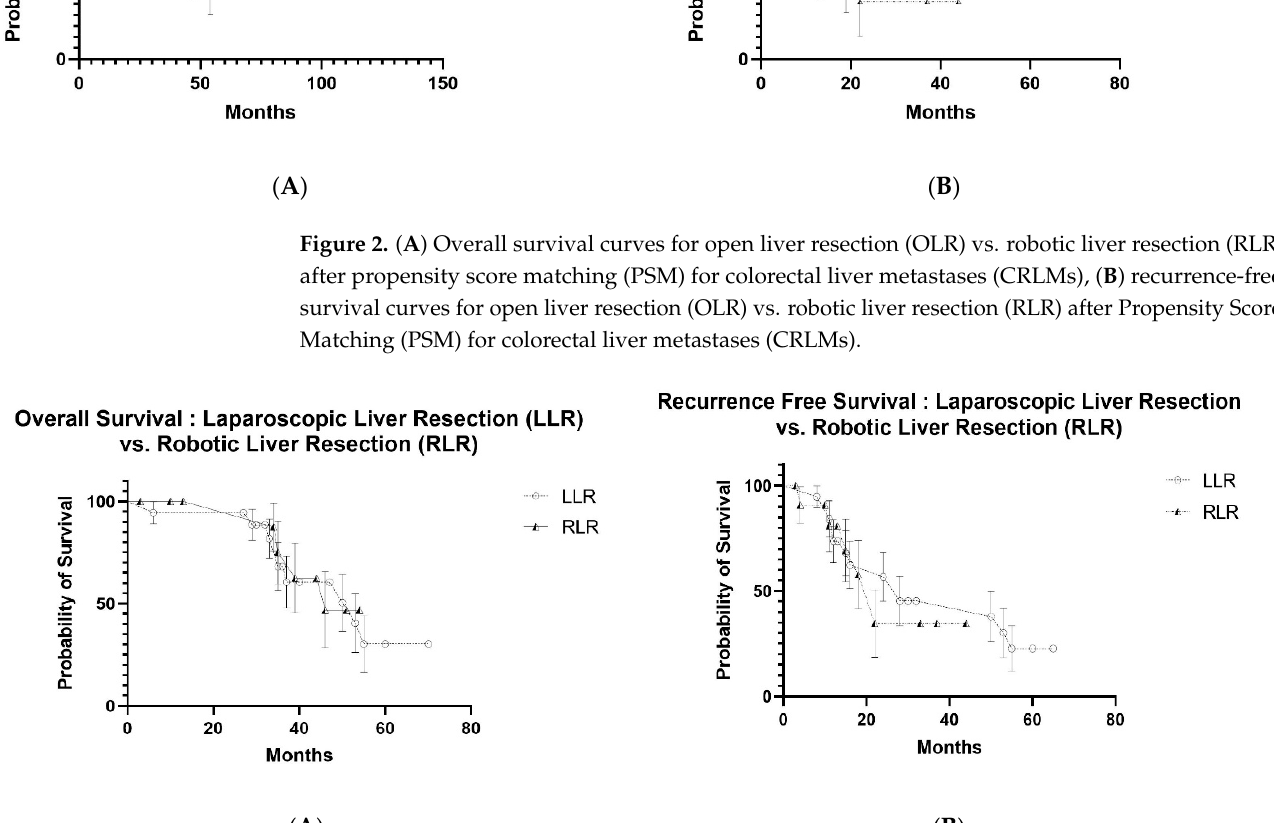
Figure 3. ( A ) Overall survival curves for laparoscopic liver resection (LLR) vs. robotic liver resection (RLR) after propensity score matching (PSM) for colorectal liver metastases (CRLM), ( B ) recurrence-free survival curves for laparoscopic liver resection (LLR) vs. robotic liver resection (RLR) after propensity score matching (PSM) for colorectal liver metastases (CRLMs). Recurrence-free survival (RFS) at 1, 3 and 5 years was 61.0%, 30.5% and 12.1% with a